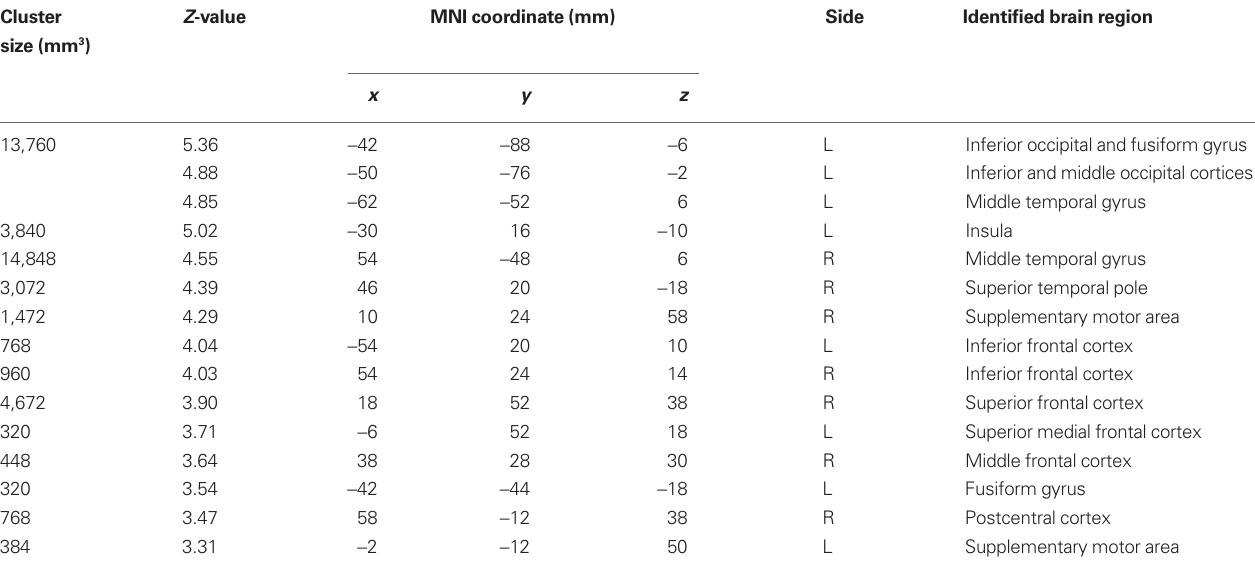
Table 3 | Brain regions with psychophysiological interaction with the thalamus cluster “minus habenula” during stop error > stop success ( p < 0.001,